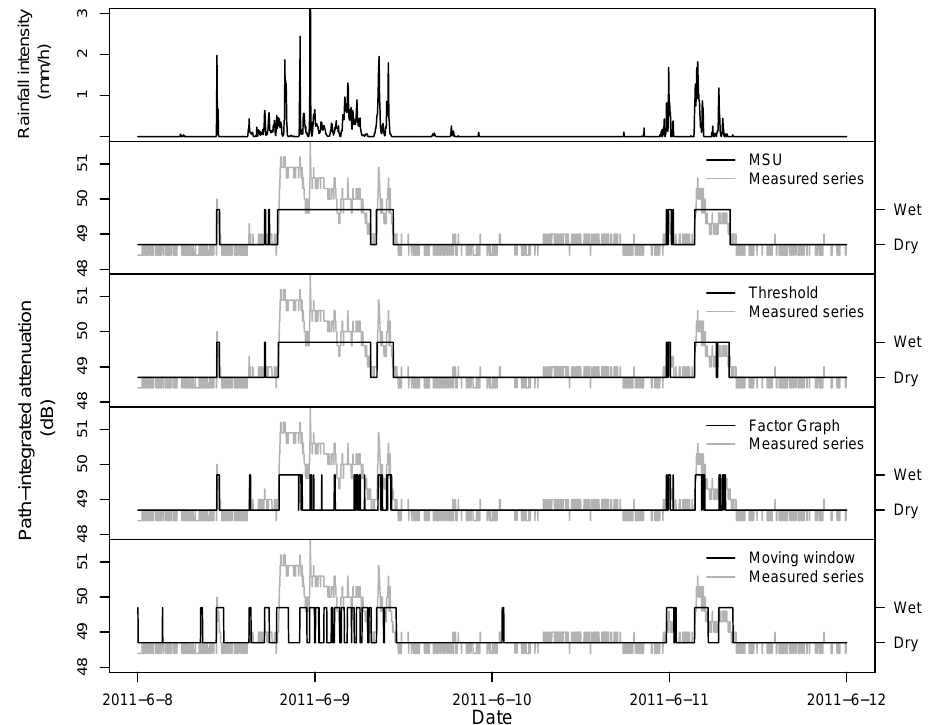
Fig. 15. Empirical probability density functions of attenuation val- ues for dry and rainy periods (for dataset 1). The dashed lines repre- sent the fitted densities of a Gaussian distribution with same mean and variance as the samples. The dry and rainy periods are derived from the disdrometer data.